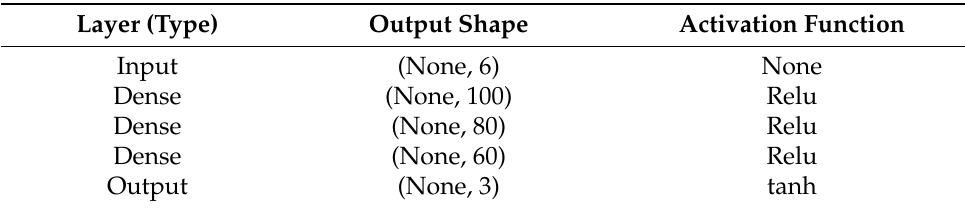
Table 4. The architecture of network for learning nonlinear problem.